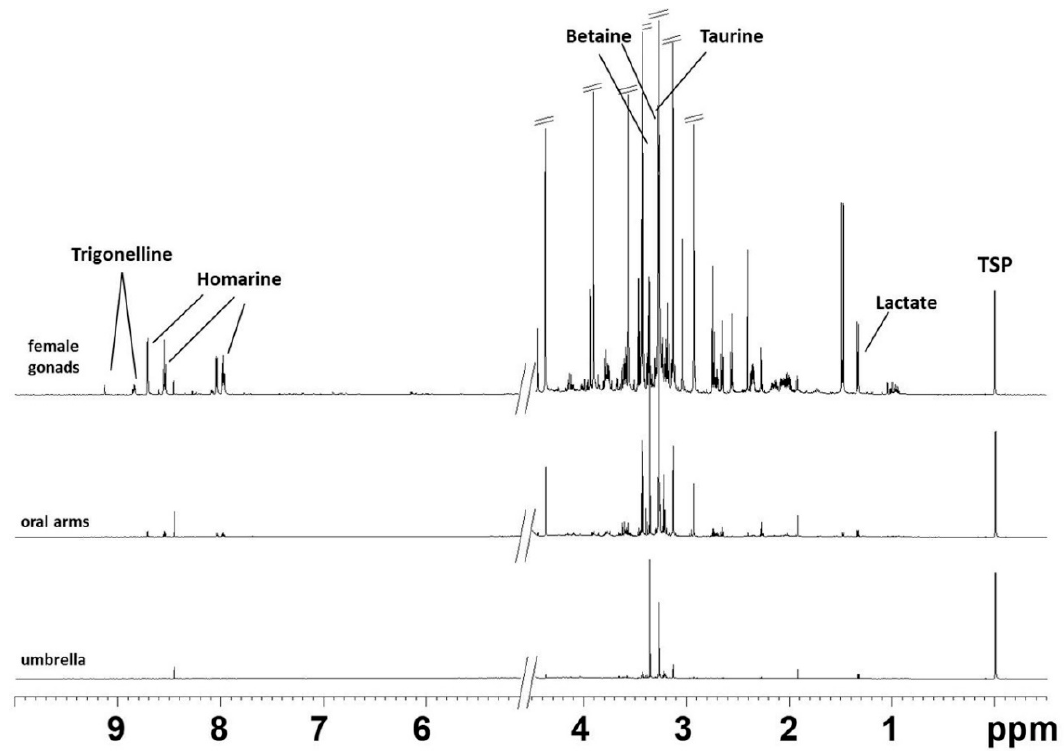
Figure 2. Typical 1 H NMR spectrum obtained at 600 MHz of D 2 O aqueous extract of different body compartments of R. pulmo (female gonads, oral arms, umbrella). Table 2. Chemical shifts and assignments of main peaks in the 1 H NMR spectra of D 2 O extracts of the three different body compartments of R. pulmo (d: doublet; dd: double of doublets; t: triplet; m: multiplet; s: singlet). a Essential amino acid; TMAO: trimethylamine-N-oxide.